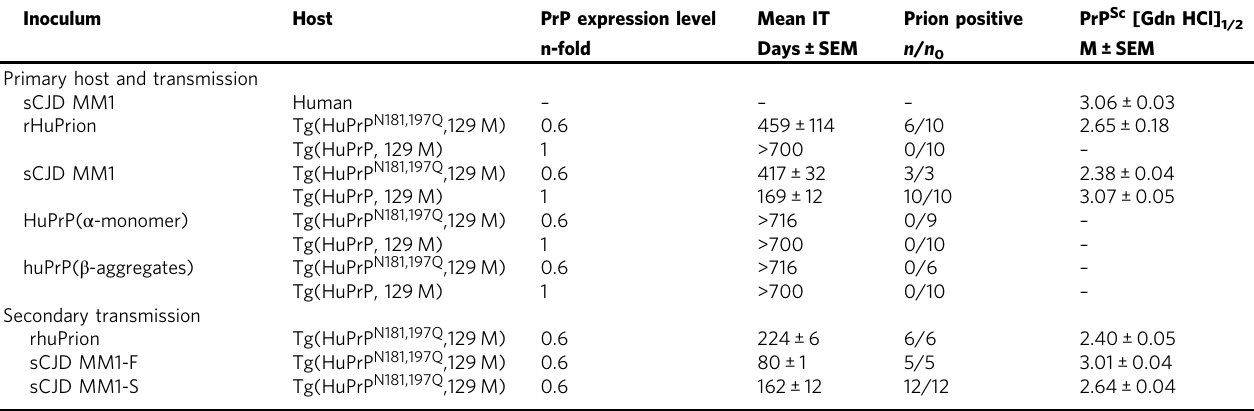
Table 1 Serial transmission experiments in transgenic mice expressing glycosylated and unglycosylated human PrP(129 M)